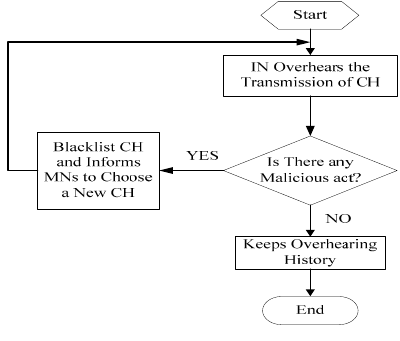
Figure 3. IN’s inspection of the CH.